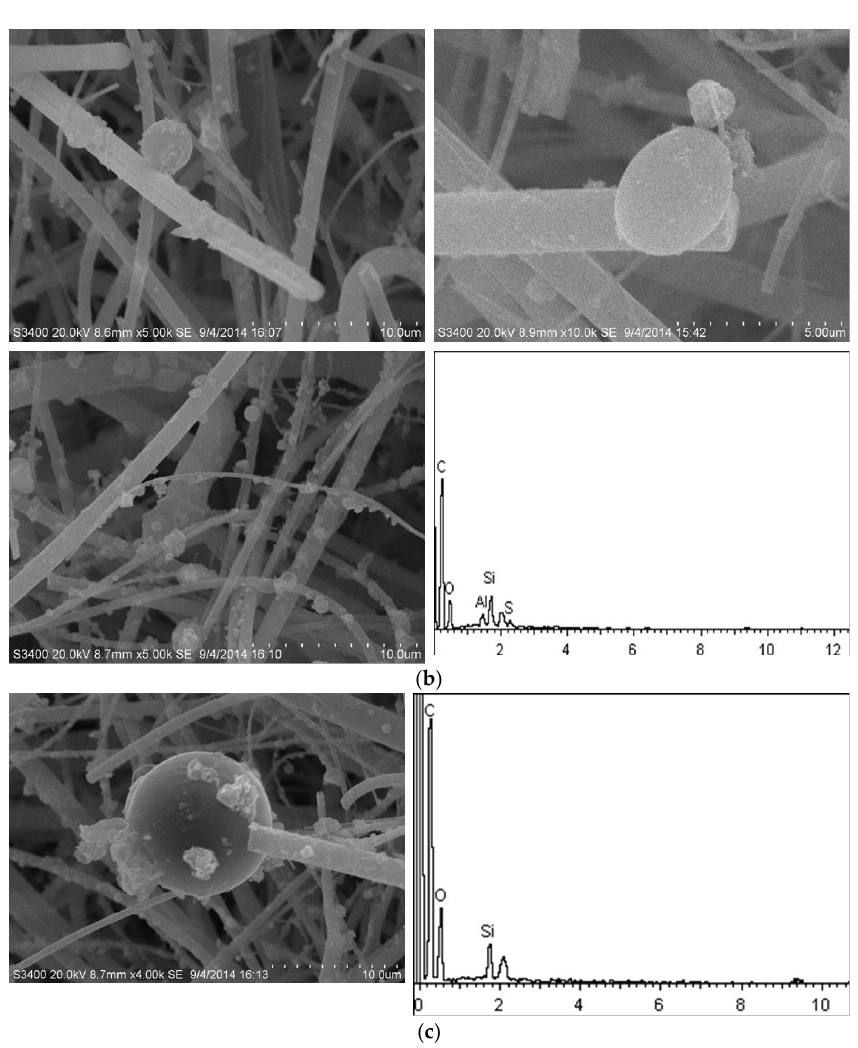
Figure 7. SEM/EDS photomicrographs of ( a ) mineral particles; ( b ) fly ash, quartz particles; ( c ) carbon particles.